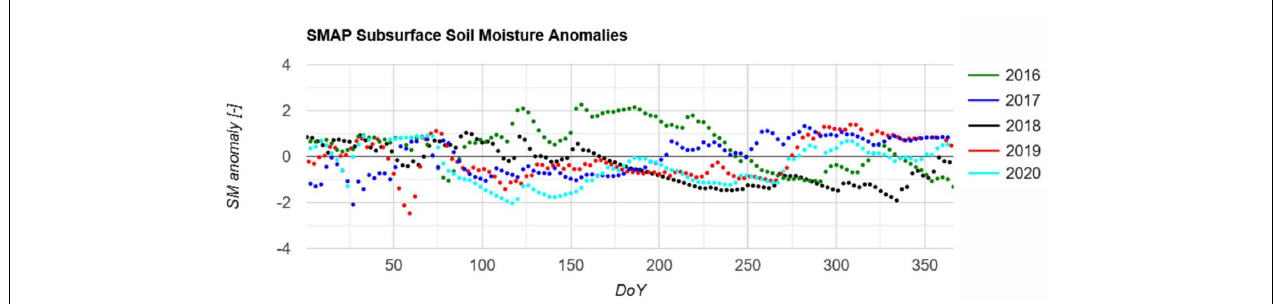
FIGURE 3 | SMAP subsurface soil moisture anomalies for the years 2016–2020 averaged over the area of investigation. Anomalies were calculated with respect to the reference period 2015–2020. Due to the non-continuous 2–3 day acquisitions of SMAP it is shown as a point diagram.